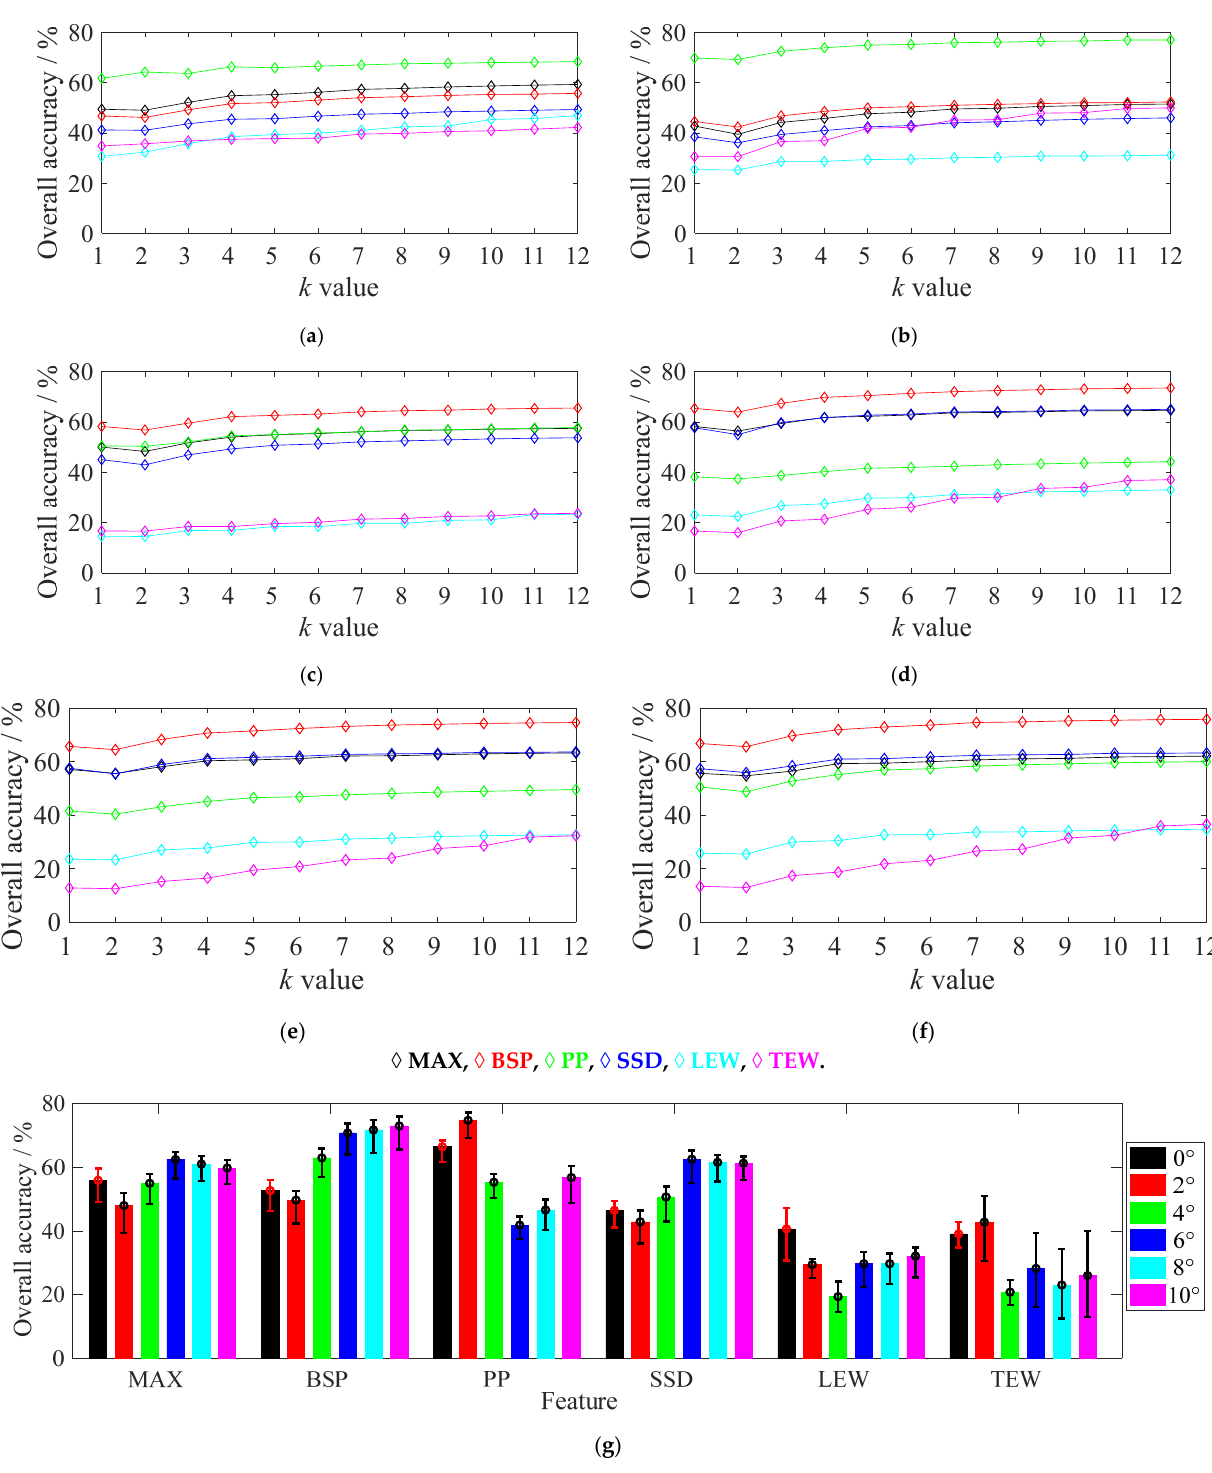
Figure 9. ( a – f ) Overall accuracies of six waveform features for different k values at small incidence angles: ( a ) 0°; ( b ) 2°; ( c ) 4°; ( d ) 6°; ( e ) 8°; ( f ) 10°. ( g ) Mean values of the overall accuracies are expressed by the bars, and the maximum value and minimum value of the overall accuracies are indicated by the error bars.